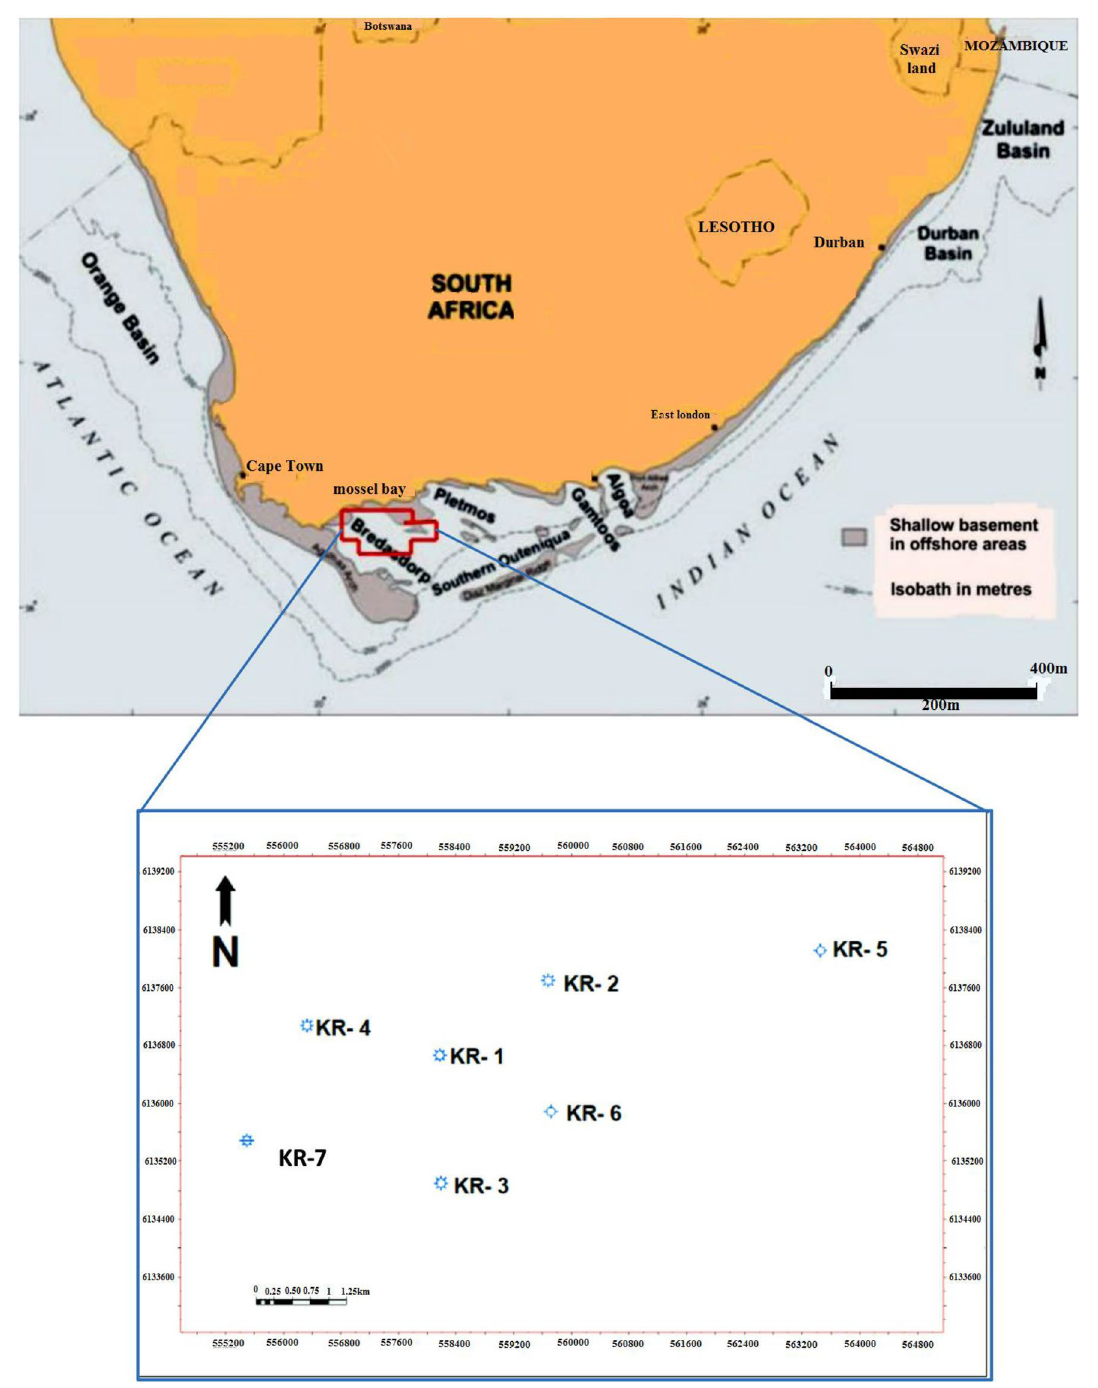
Fig. 1 Map showing the location of KR field, Bredasdorp Basin (modified after Petroleum South Africa